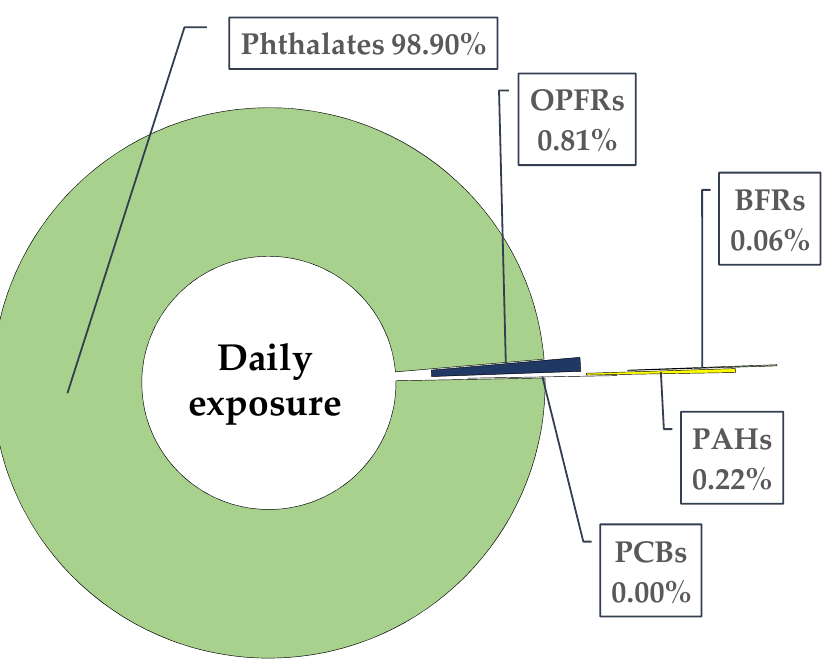
Figure 4. Chemical profile (%) of daily exposure from car dust based on median values (ng/kg BW/day).